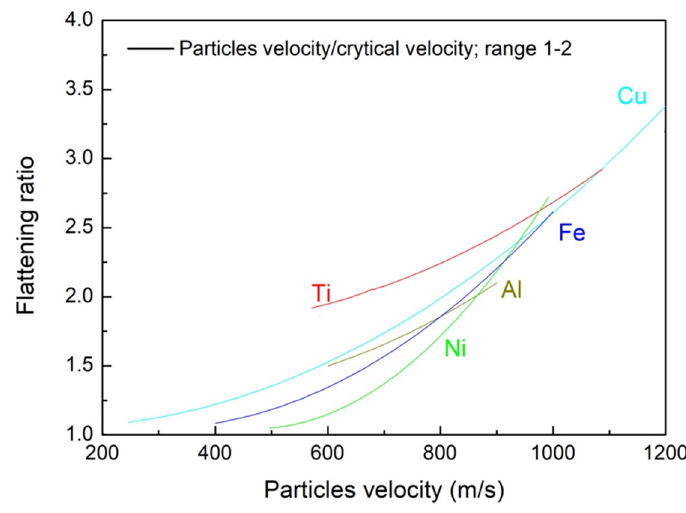
Figure 10. Flattening ratio as a function of the particle velocity.